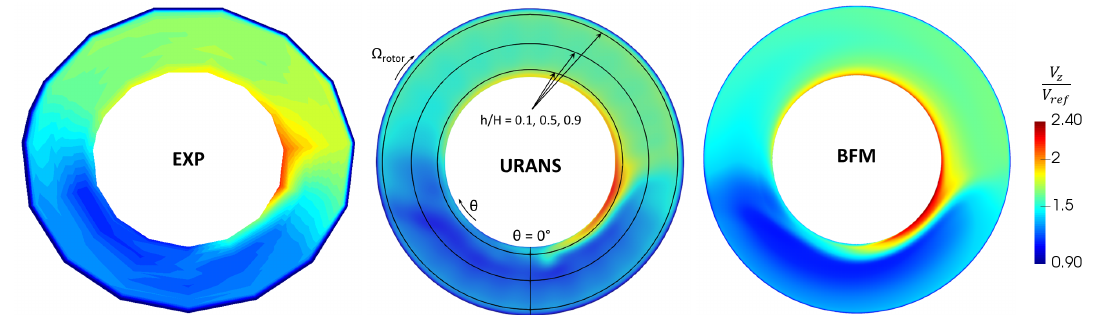
Figure 12. Axial velocity field in Section